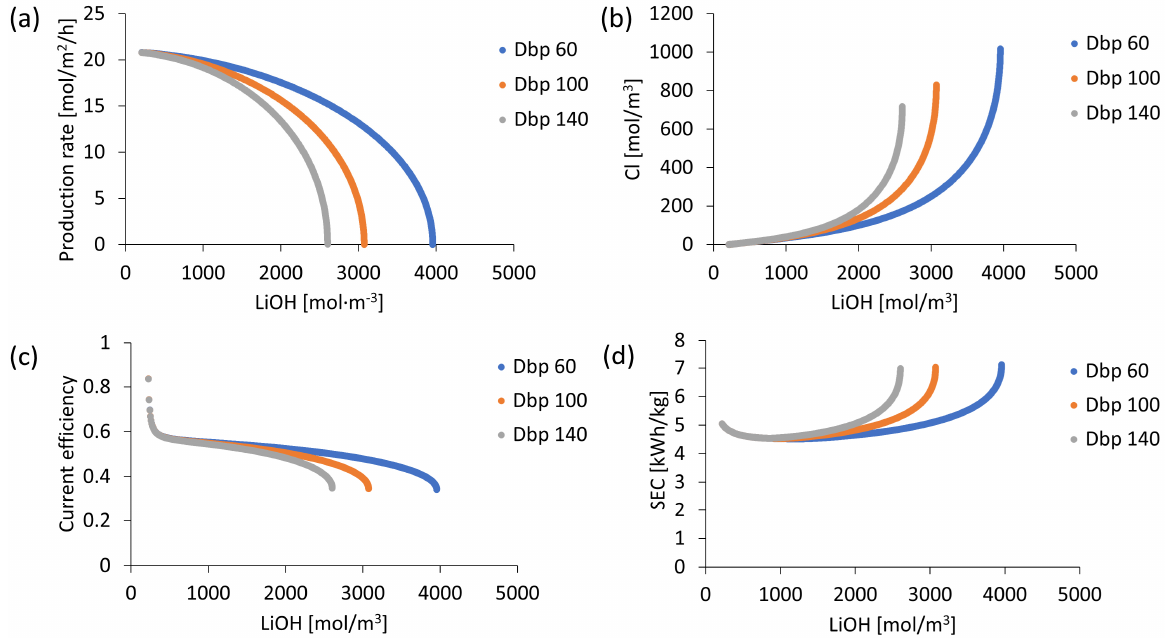
Figure 5. Process performance according to the average diffusion coefficient in the bipolar mem- brane ranges from 60 × 10 − 12 to 140 × 10 − 12 m 2 /s (Dbp 60 to Dbp 140 in the graph, respectively): ( a ) LiOH production rate; ( b ) Cl − concentration; ( c ) Current efficiency; ( d ) Specific electricity con- sumption